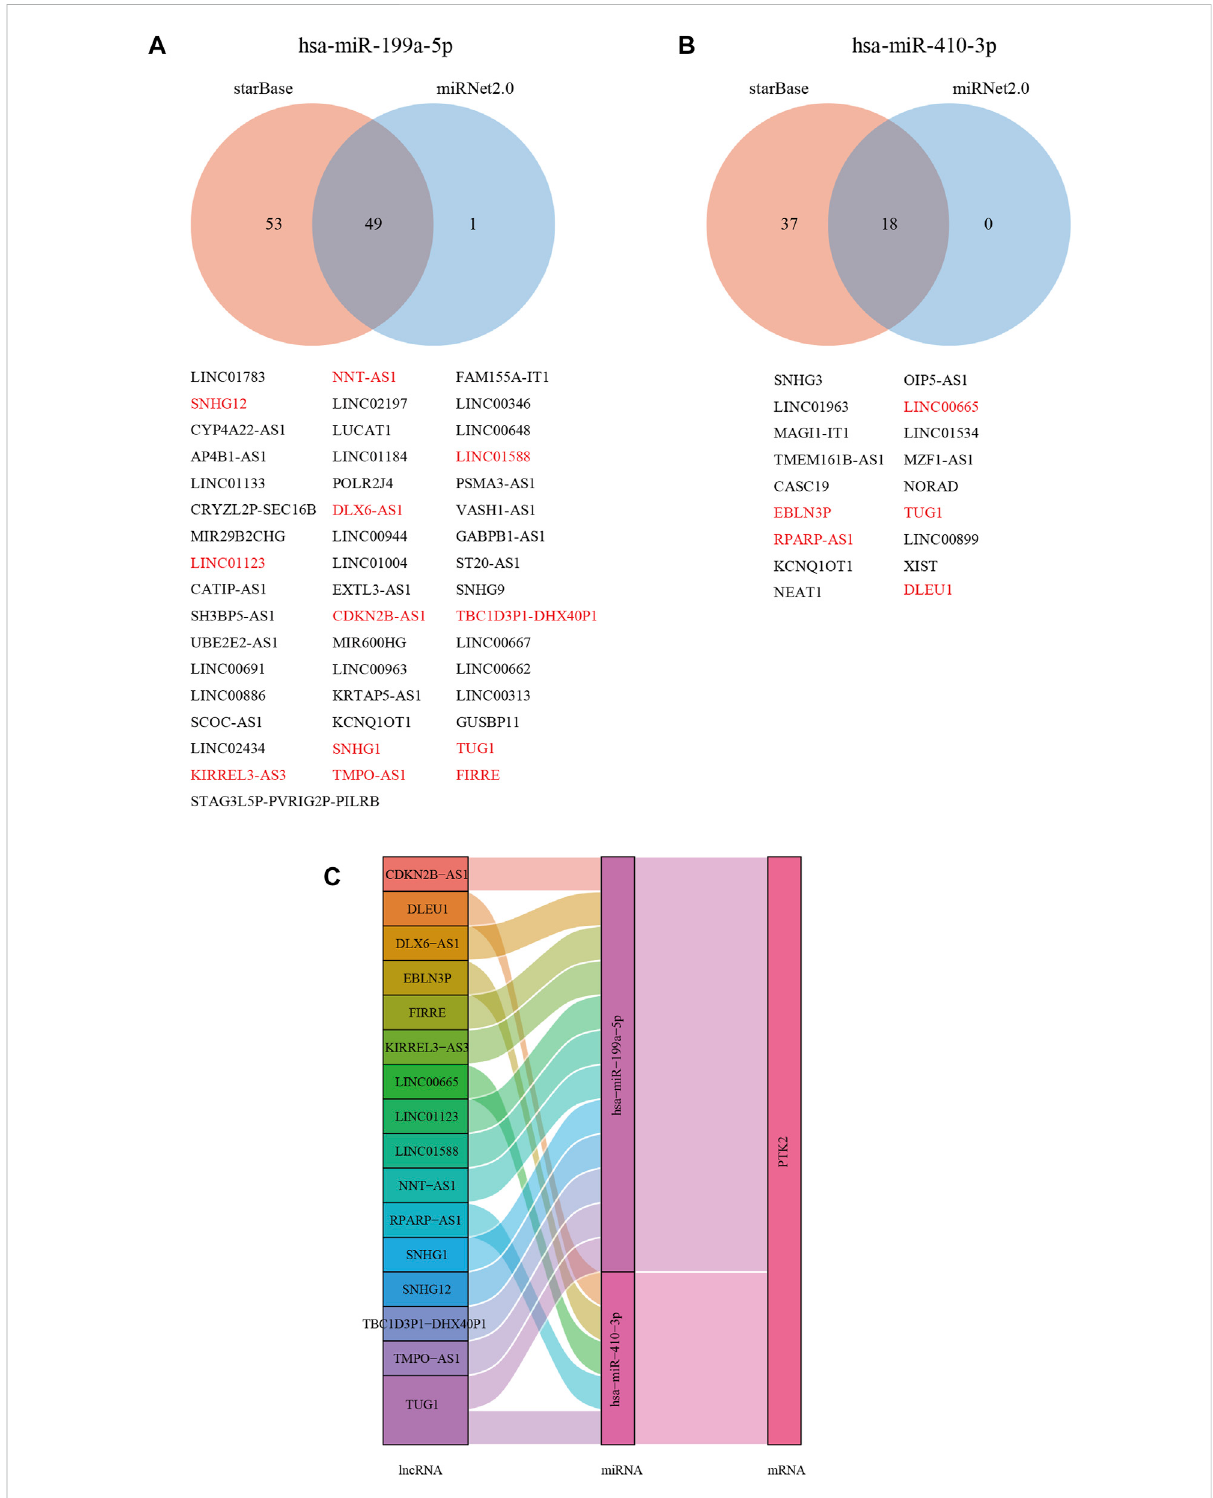
FIGURE 9 Construction of lncRNA and ceRNA network in breast cancer. The Venn diagram shows the target lncRNA of hsa-miR-199a-5p (A) and hsa- miR-410-3p (B) . Red (negative correlation with miRNAs). (C) Hypothesis of the lncRNA – miRNA – mRNA (PTK2) regulatory network shown by a Sankey